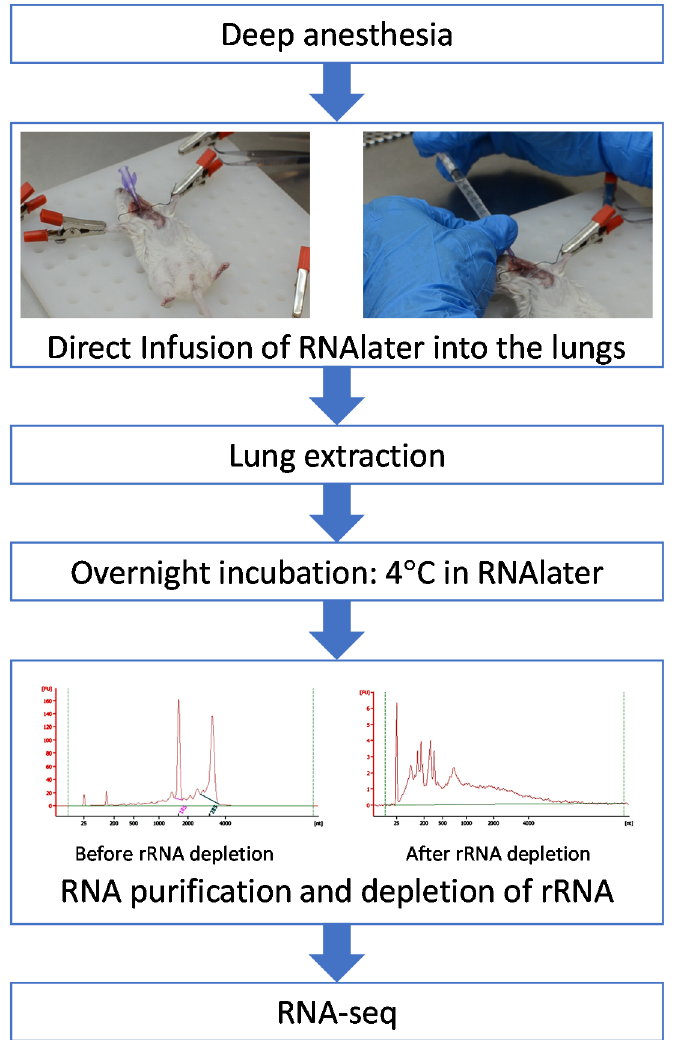
Figure 1. Flow chart of the method, from murine lung collection for RNA extraction to RNA-seq analysis. The upper panels illustrate the infusion of RNAlater into the mouse lungs through the trachea under deep anesthesia. The rRNA depletion step shown as follows: On the left, RIN analysis of high-quality total RNA (RIN = 8.7) extracted from mouse lungs. On the right, the same sample after rRNA depletion. Note the enrichment of the mRNA fraction and the virtually complete removal of the mammalian rRNAs 18S and 28S rRNAs (in pink and green on the left panel) and the bacterial 16S and 23S